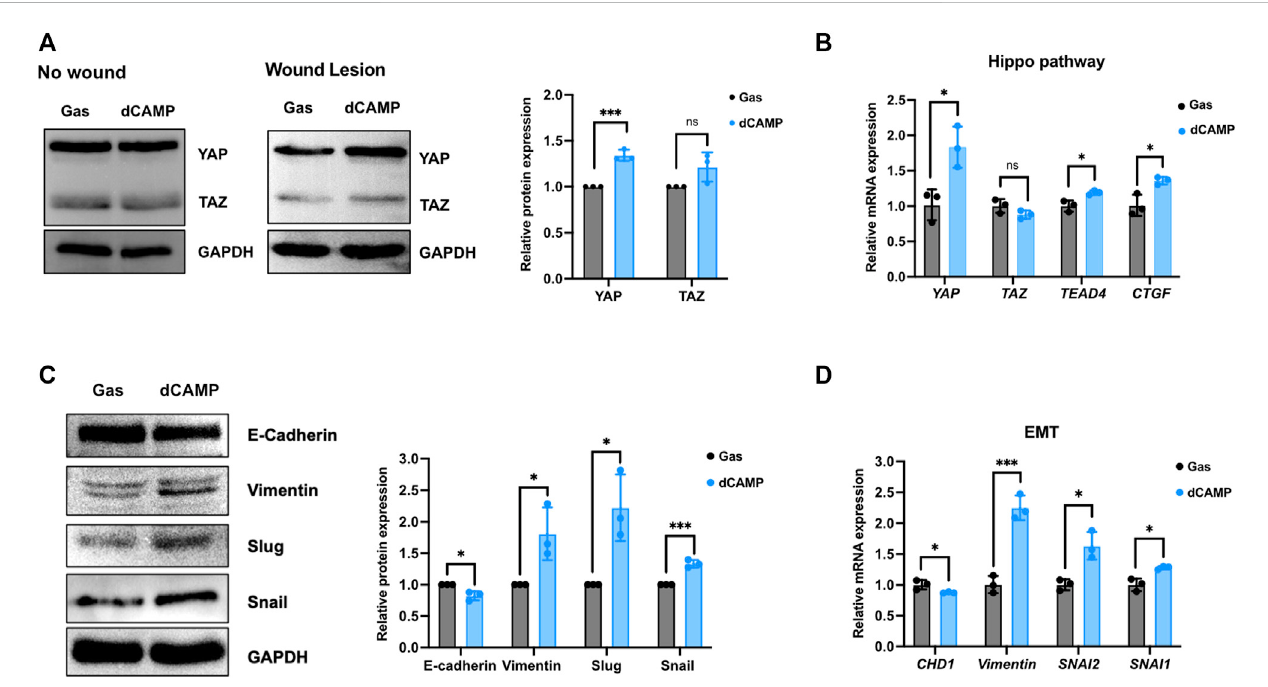
FIGURE 6 Direct CAMP treatment plays roles in EMT and Hippo pathway contributing to promoting wound-healing activity in canine keratinocytes. (A) DownstreamtargetsoftheHippopathway,YAPandTAZproteinexpression,undernormalconditions(nowound)andwoundconditions(woundlesions)after treatmentwith30-sdCAMPorgas.Theadjacentgraphpresentsthequantitativeexpressionoftherelativeproteins. (B) qRT-PCRdataveri fi edthemRNAgene expressionintheHippopathway.Immunoblotting (C) andqRT-PCR (D) resultsshowthat30-sdCAMPimprovedcellmigrationbyinducingEMTmarkers. Data are presented as mean ± standard error, * p < 0.05, ** p < 0.01, and *** p < 0.001 compared with the gas-treated